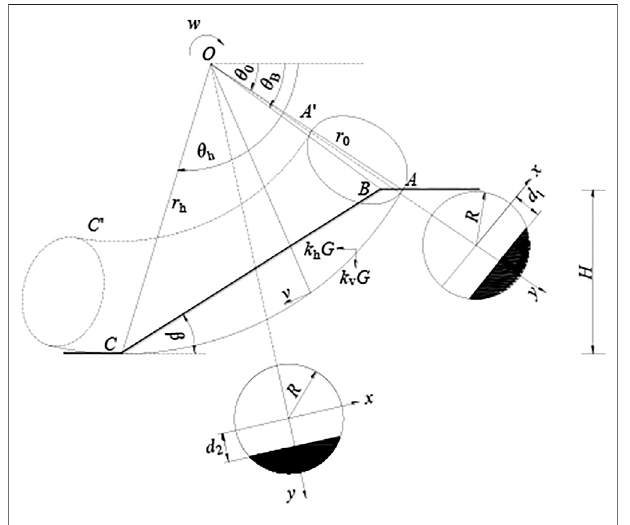
FIGURE 1 | 3D rotational failure